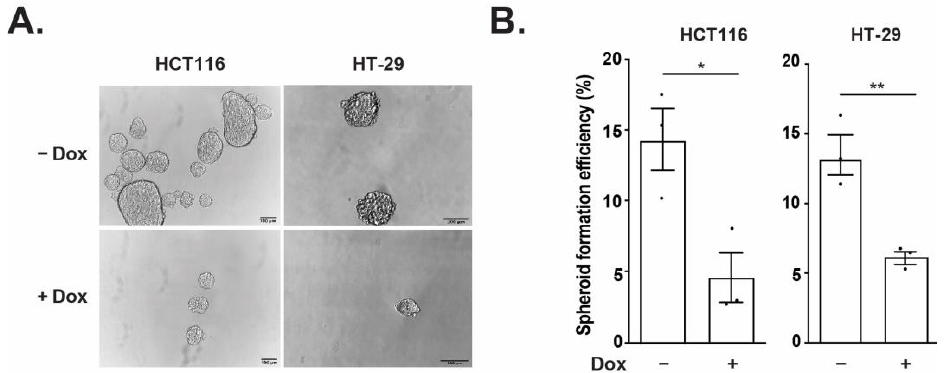
Figure 4. TCF7L1 reduces spheroid formation efficiency of CRC cell lines. ( A ) Representative images of spheroids formed in untreated (ctrl) and Dox-treated FLAG-TCF7L1 HCT116 and FLAG-TCF7L1 HT-29 cell lines. Scale bars are 100 µm. ( B ) Average spheroid formation efficiency of spheroids derived from FLAG-TCF7L1 HCT116 and FLAG-TCF7L1 HT29 cells ± Dox treatment. Data are represented as mean ± SEM. (* p < 0.05, ** p < 0.01).